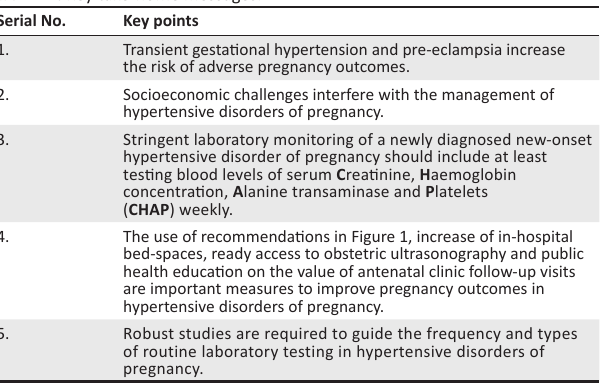
Figure 1. Additional algorithms on approach to HDP for